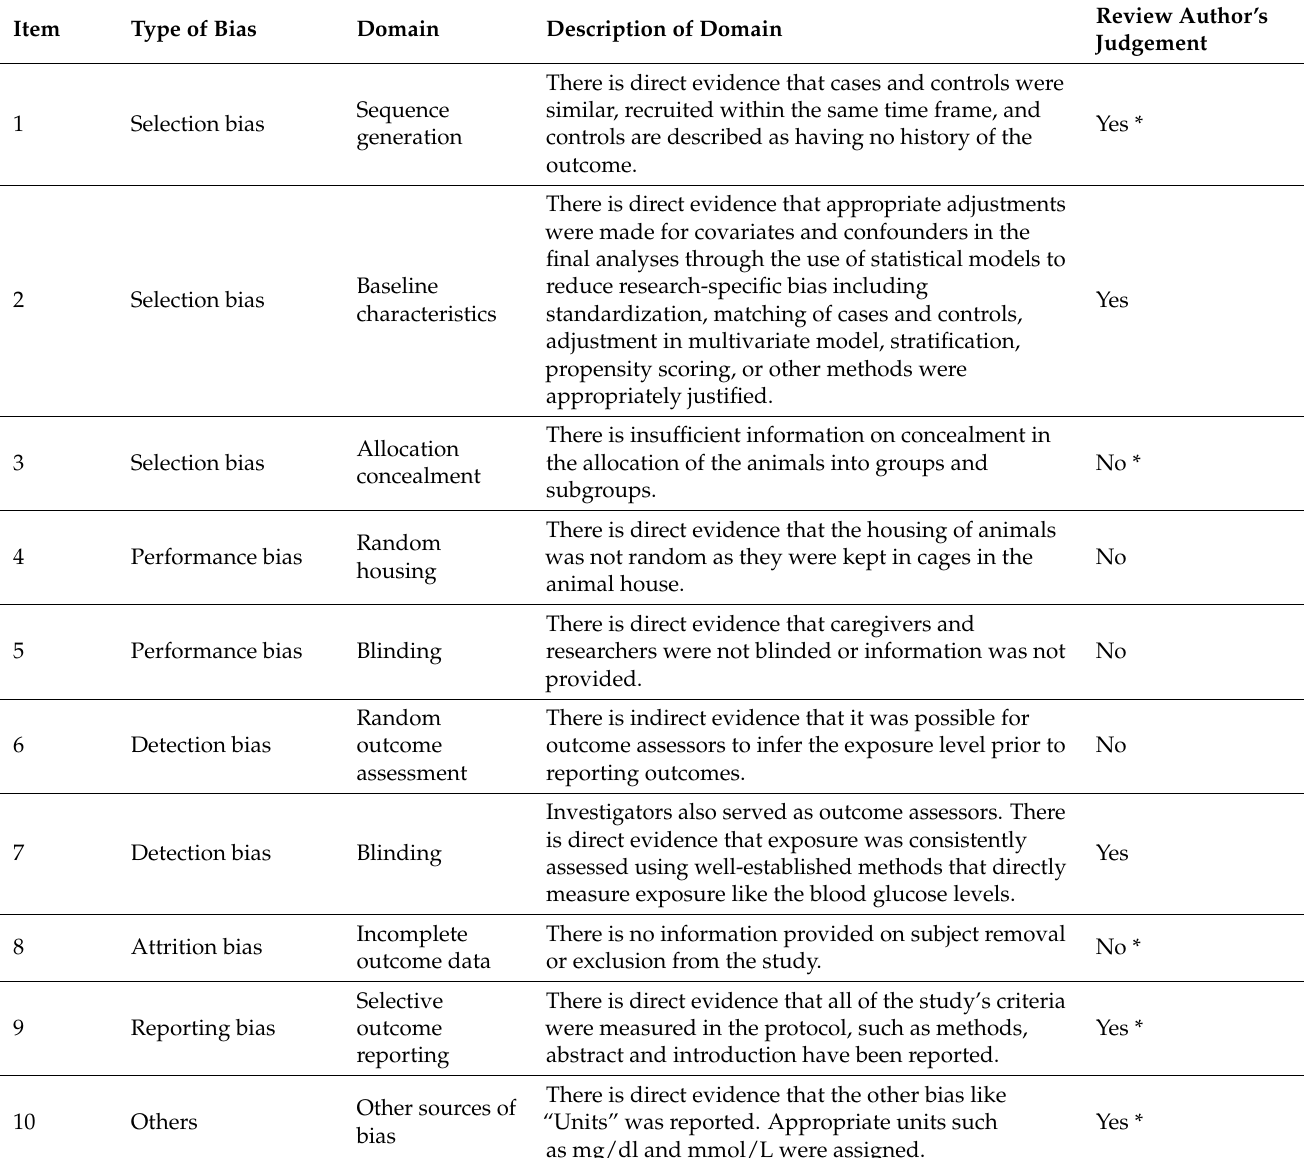
Table 3. Use of SYRCLE’s tool for assessing risk of